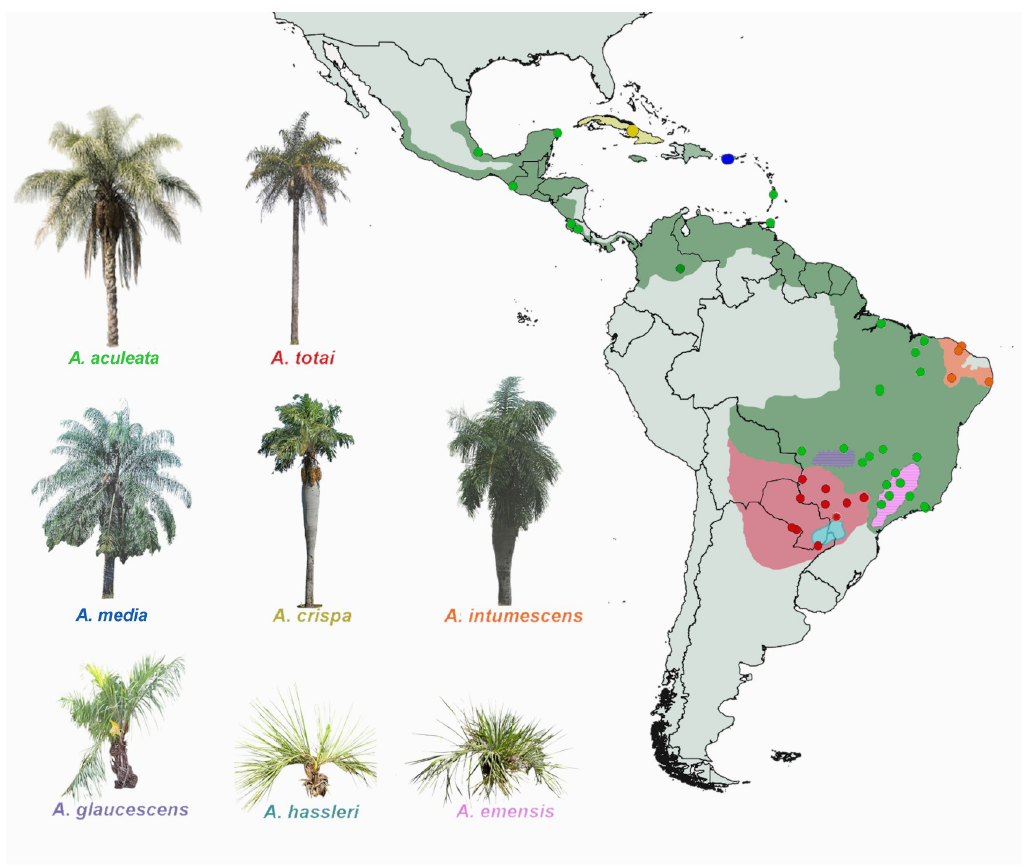
Fig 1. Schematic map of Acrocomia species distribution and geographic location and origin of samples. Data used to generate the species distribution (Colored shading) are based on occurrence record data from GBIF (Global Biodiversity Information Facility www.gbif.org) and [4]. Circles represent geographical location and origin of samples in this study. Image sources: A . aculeata , A . totai , A . hassleri , A . glaucescens . A . emensis (B. G. Dı´az); A . intumescens ; A . media and A . crispa (S. A.